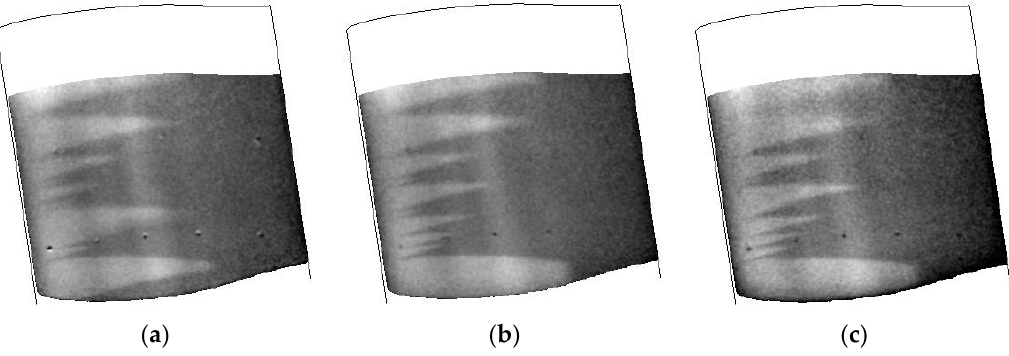
Figure 11. Temperature images collected at different tunnel temperatures during a CNT heating cycle. Data were collected at Mach 0.3, Re = 32.8 M/m: ( a ) 110 K; ( b ) 172 K; and ( c ) 200 K.